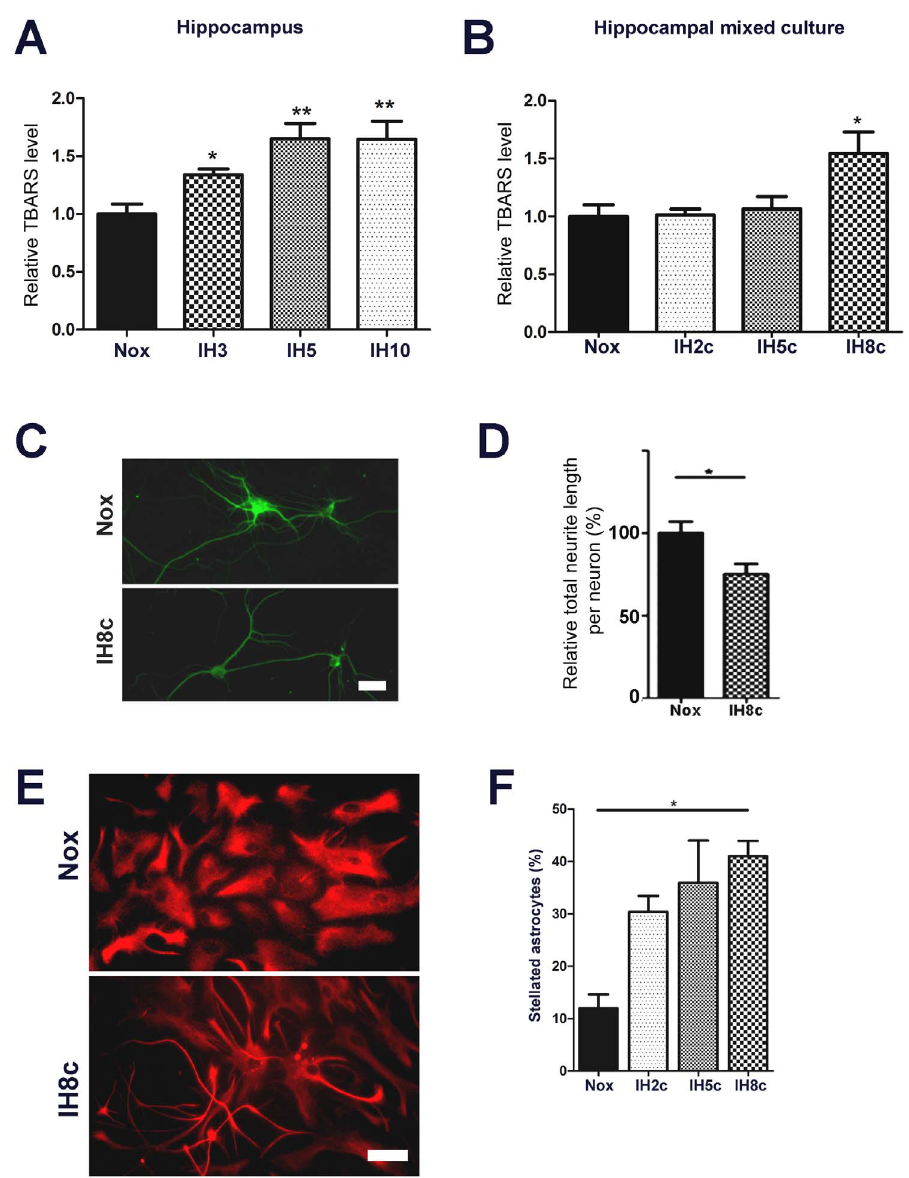
Figure 1. IH-exposed dissociated mixed hippocampal cell culture reproduces several features of in vivo IH exposure. A: Relative TBARS content in the hippocampus of animals exposed to normoxia (Nox) or to IH for 3, 5 or 10 days (IH3, IH5, IH10). B: Relative TBARS content in the dissociated mixed hippocampal cell culture exposed to normoxia (Nox) or to 2, 5, or 8 cycles of IH (IH2c, IH5c, IH8c). C: Beta-3-tubulin immunostained hippocampal neurons in the dissociated mixed hippocampal culture exposed to normoxia (Nox) or 8 cycles of IH (IH8c), bar =20 m m. D: Quantitative analysis of the relative neurite length in the hippocampal neurons in the mixed culture exposed to normoxia (Nox) or 8 cycles of IH (IH8c). E: GFAP immunostained astrocytes in the dissociated mixed hippocampal culture exposed to normoxia (Nox) or 8 cycles of IH (IH8c), bar =23 m m. F: Quantitative analysis of astroglial stellation followed by the phenotypic change in the GFAP-immunoreactive astrocytes after 2, 5, or 8 cycles of IH (IH2c, IH5c, IH8c). Data on the graphs are shown as means 6 SEM; significance vs. control group was represented as indicated: * p , 0.05; **p , 0.01; *** p , 0.001 after one way ANOVA and Student Newman Keuls post-test.